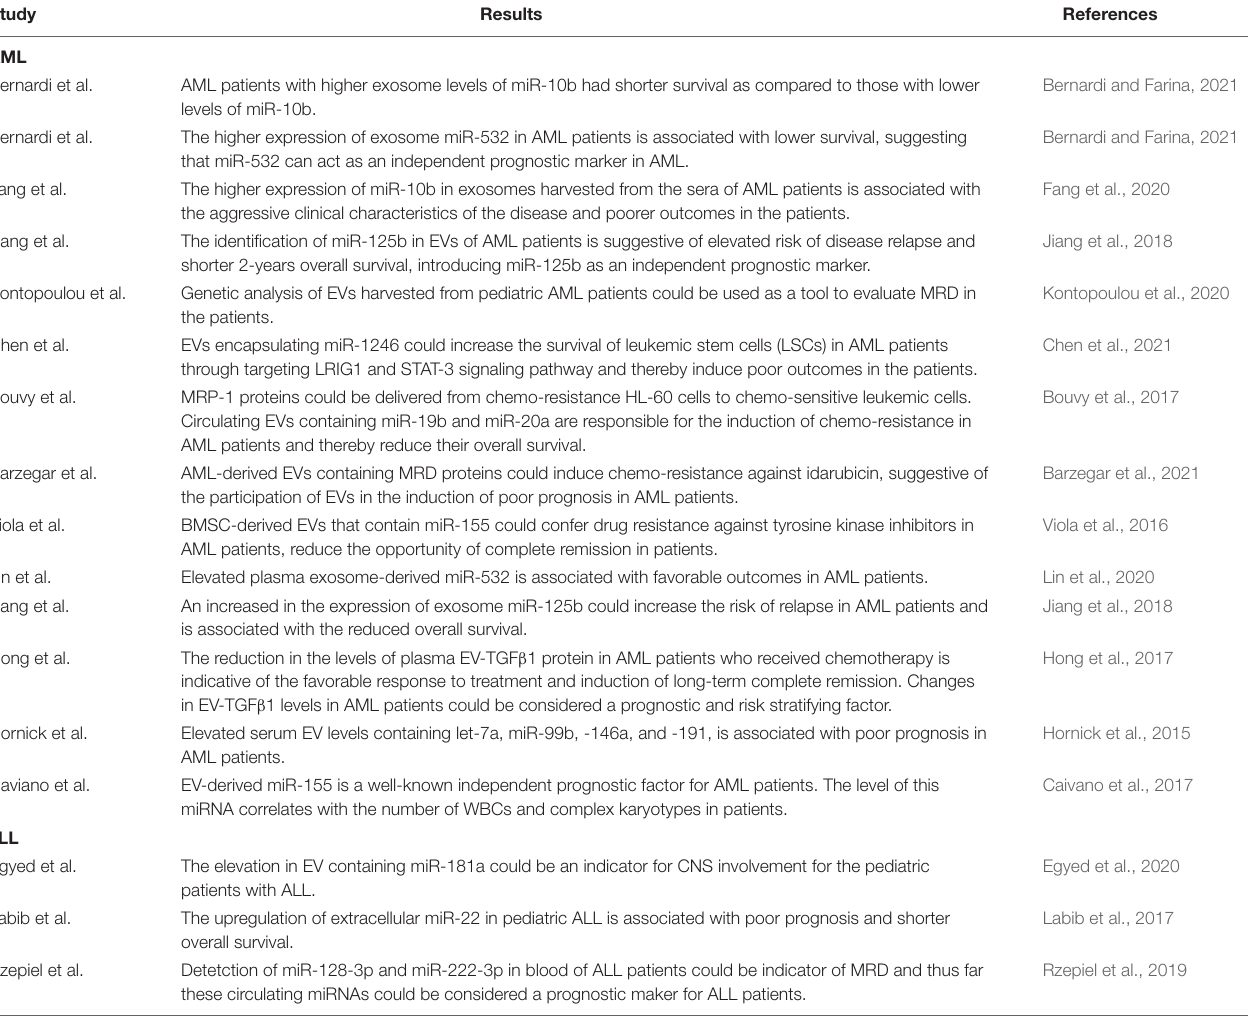
TABLE 2 | The correlation between leukemia-derived EVs and the outcome of patients. Study